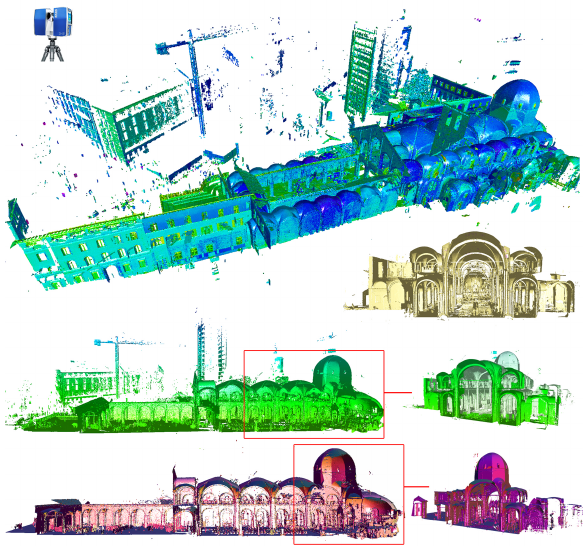
Figure 3. The post-processing phase: orientation, cleaning and creation of different layers of point cloud data for the generative process of scan-to-BIM